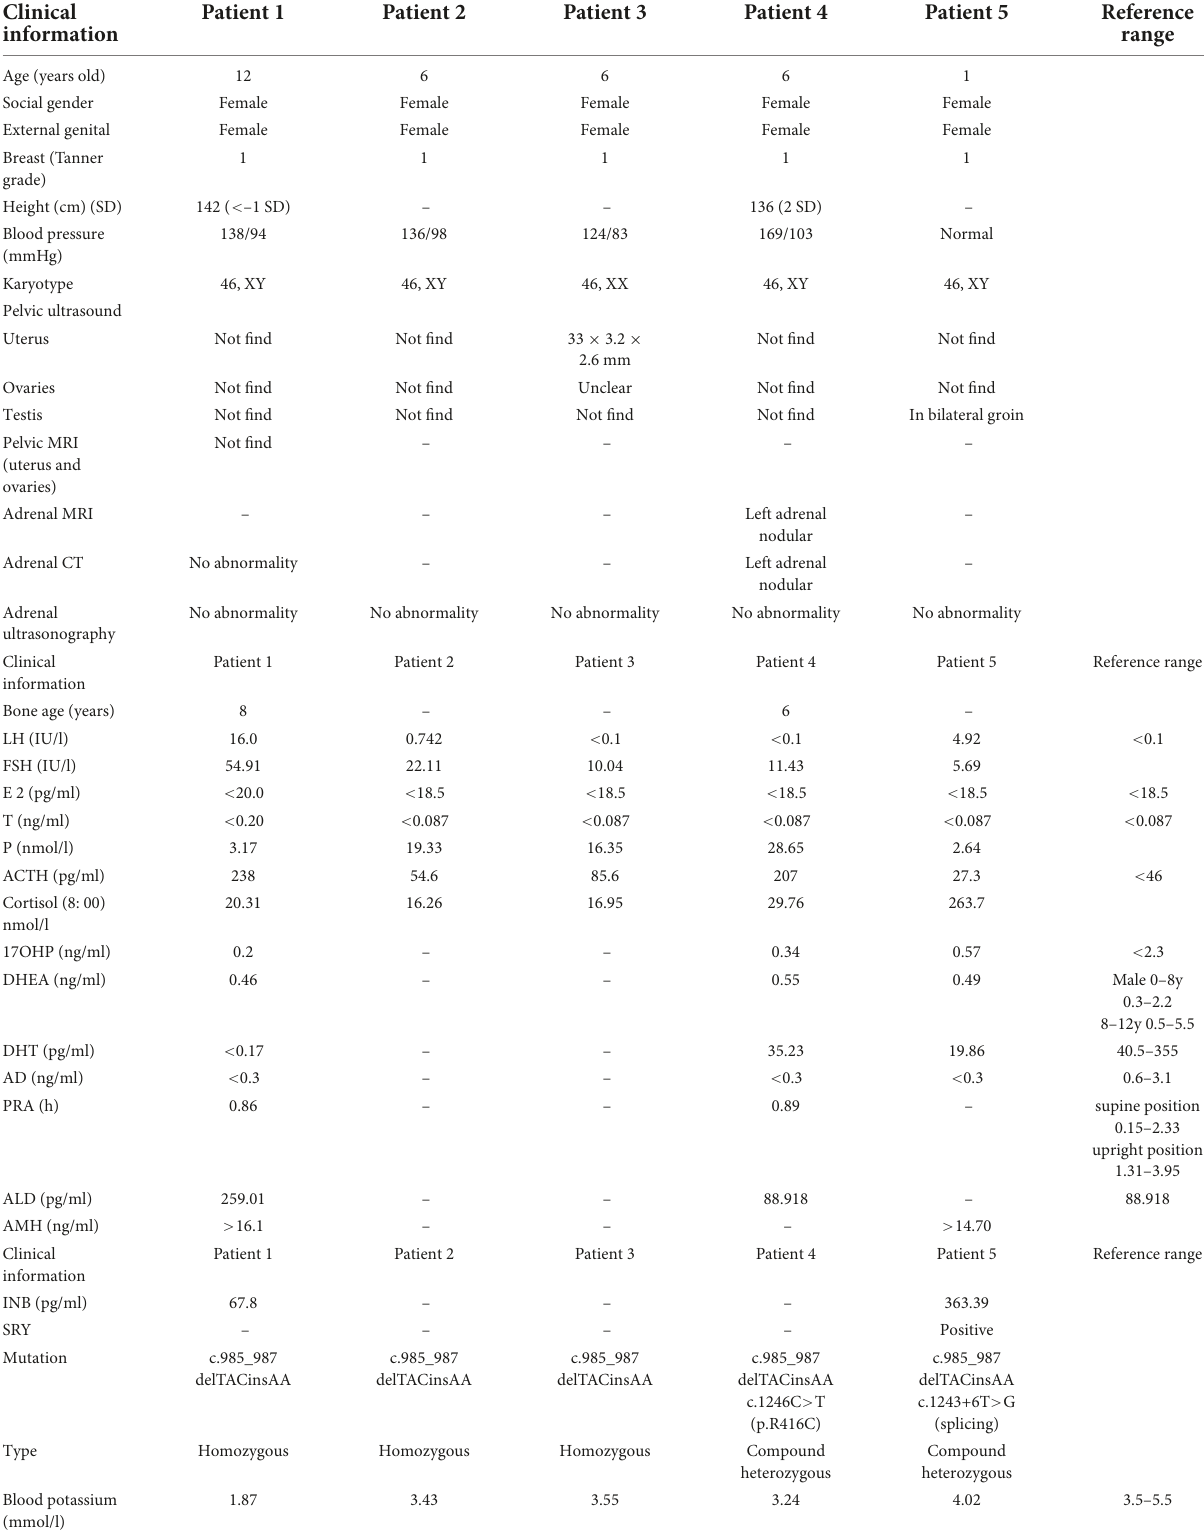
TABLE 1 Clinical characteristics, biochemical, hormonal, and mutation findings of five 17 α -hydroxylase deficiency cases. Clinical